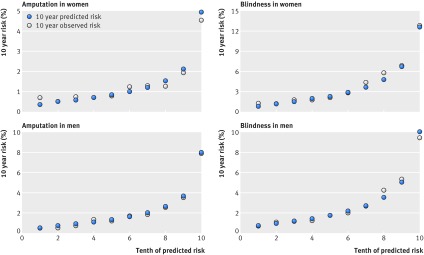
Fig 4 Mean predicted risks and observed risks of blindness and lower limb amputation at 10 years by 10th of predicted risk, applying equations to all men and women in QResearch validation cohort